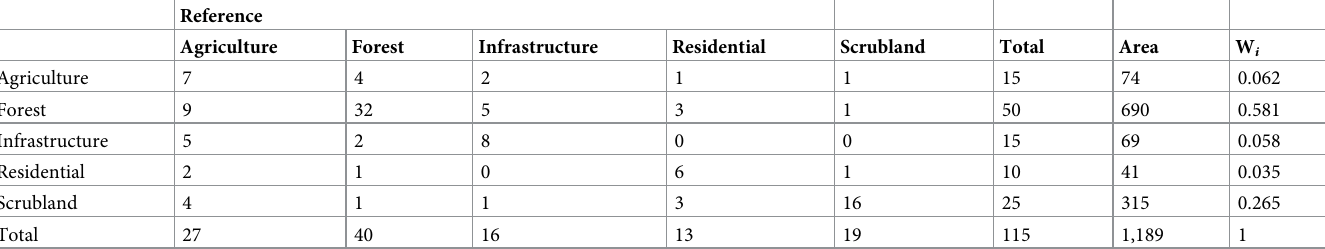
Table 3. Error matrix (sample count) for 2010 based on stratified random sampling.